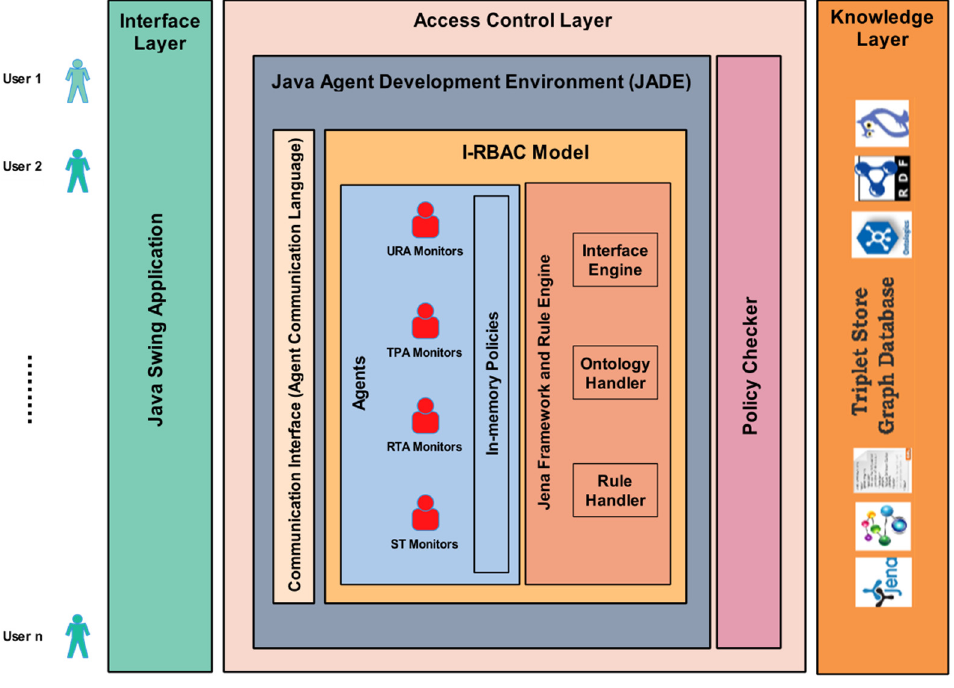
Figure 1. I-RBAC System Architecture .